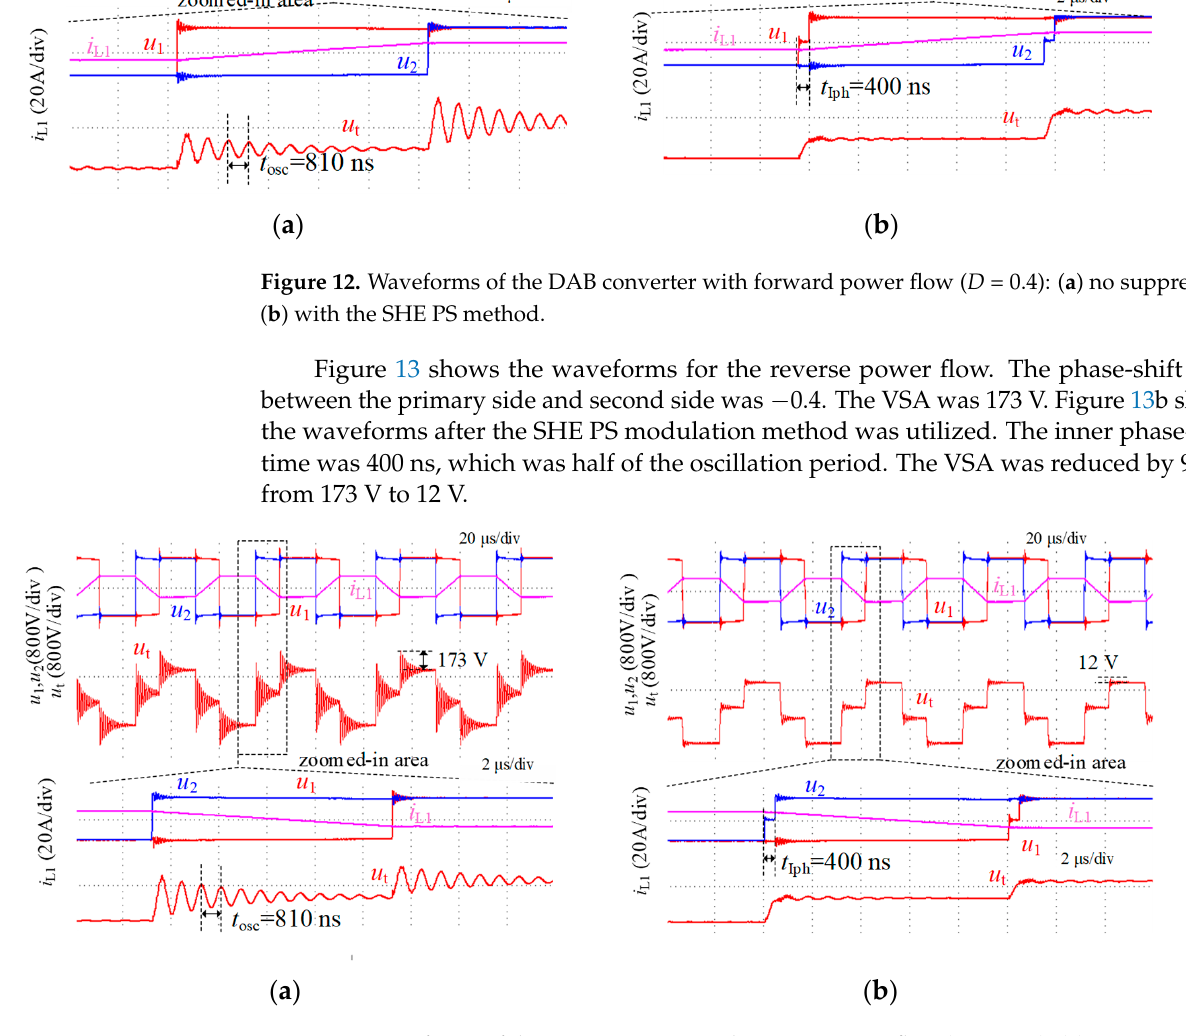
Figure 13. Waveforms of the DAB converter with reverse power flow ( D = − 0.4): ( a ) no suppression; ( b ) with SHE PS method.